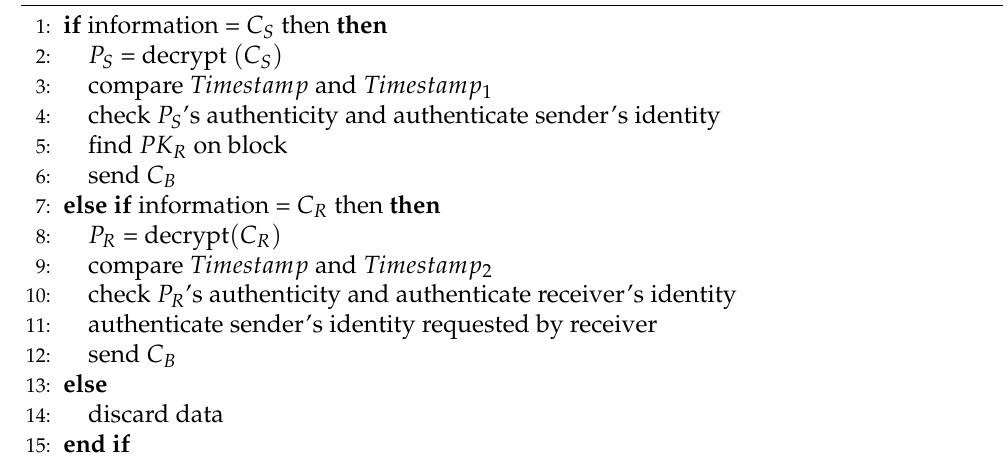
Algorithm 2 Blockchain processing